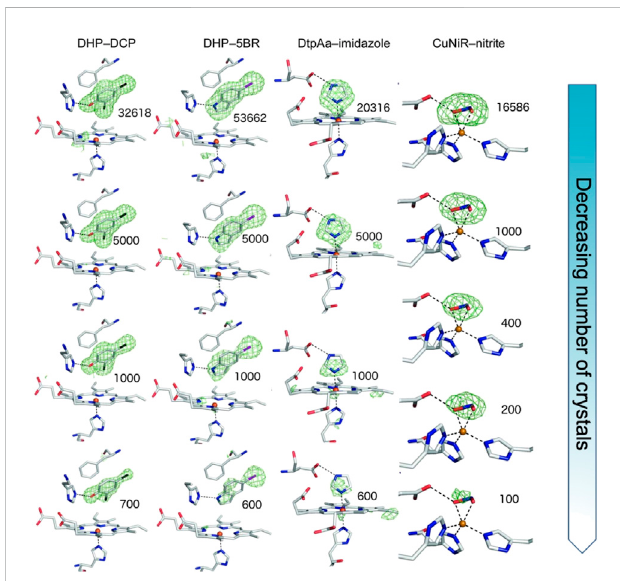
FIGURE 1 SFX results showing Fo-Fc simulating annealing OMIT electron density contoured at 3 σ (green) for different sizes of ligands in theactive sitepocket(depictedinsticks)oftheenzymesdehaloperoxidaseB(DHP) from Amphitrite ornata , dye-type decolorizing peroxidase Aa (DtpAa)from Streptomyceslividans andcoppernitritereductase(CuNiR) from Achromobacter cycolclastes . The ligands 2, 4 dichlorophenol (DCP), 5-bromoindole (5BR), imidazole and nitrite, respectively were soaked into the microcrystals. The top row represents the full datasets obtained with subsequent rows being from subsets of the data of decreasing size, numbers shown indicating the number of diffraction patterns comprising each dataset. Remarkably, data from only a few hundred to a few thousand microcrystals reproduced the electron density for the ligand enabling accurate modelling. This result opens the door to high throughput fragment screening/structure-based drug design using SFX. Figure adapted from (Moreno-Chicano et al.,